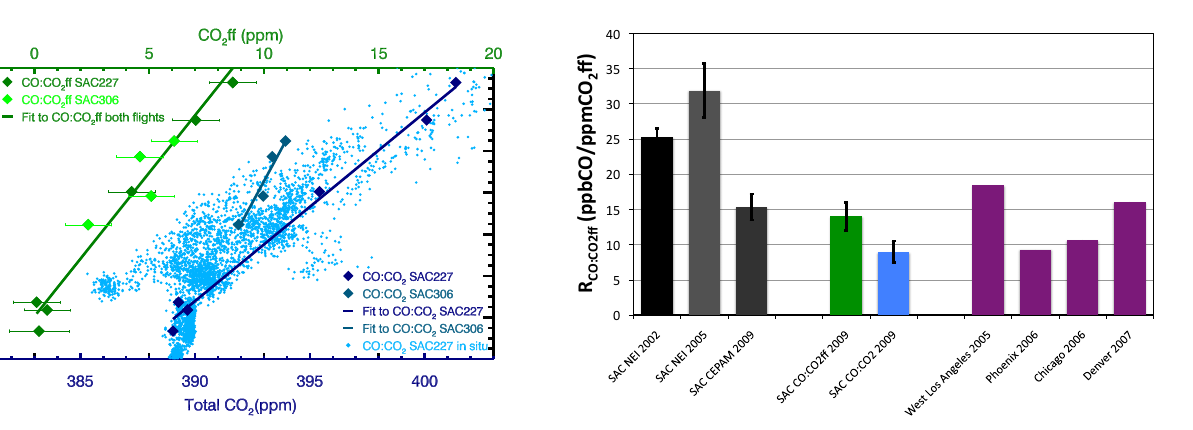
Fig. 2. Correlations between measured CO and CO 2 ff and between measured CO and total CO 2 . Flask measurements of CO:CO 2 ff are shown in green, using the top x-axis. CO:CO 2 correlations (flasks and in situ) are shown in blue, using the bottom x-axis. Error bars are the one-sigma uncertainty in CO 2 ff; uncertainties in CO and CO 2 are smaller than the symbol size. Fitted lines are linear regres- sions with errors in both coordinates.